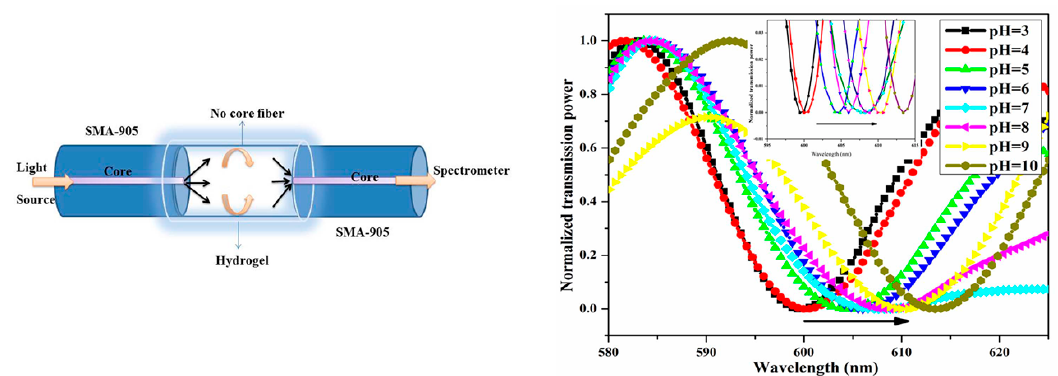
Figure 17. Hydrogel-based pH optical fiber interferometric sensor. ( Left ) Schematic representation of the optical fiber device. The NCF segment acts as interferometric cavity. ( Right ) Optical spectral response of the sensor when immersed into different pH solutions. The minima wavelength shows a direct relationship with the pH of the solution. Reprinted with permission from Ref. [101].